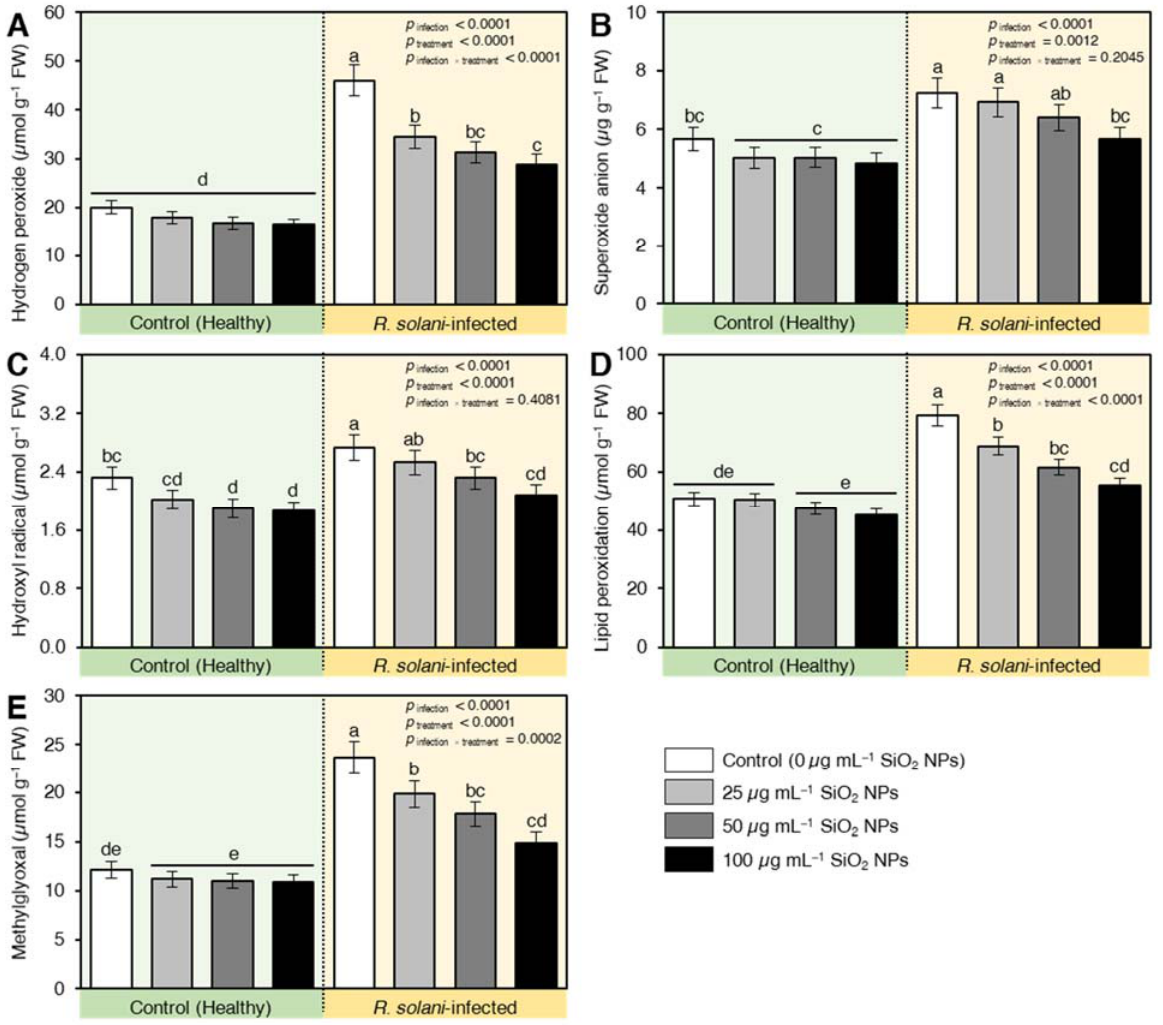
Figure 7. Effect of silicon dioxide nanoparticles (SiO 2 NPs) on oxidative stress ‐ related compounds of wheat seedlings infected by R. solani. ( A ) Hydrogen peroxide ( μ mol g − 1 FW), ( B ) Superoxide anion ( μ g g − 1 FW), ( C ) Hydroxyl radical ( μ mol g − 1 FW), ( D ) Lipid peroxidation ( μ mol g − 1 FW), and ( E ) Methylglyoxal ( μ mol g − 1 FW). Data presented are means ± standard deviation (mean ± SD) of five biological replicates. Different letters indicate statistically significant differences among treatments, while the same letters signify no significant differences between them according to Tukey’s honestly significant difference test ( p < 0.05).